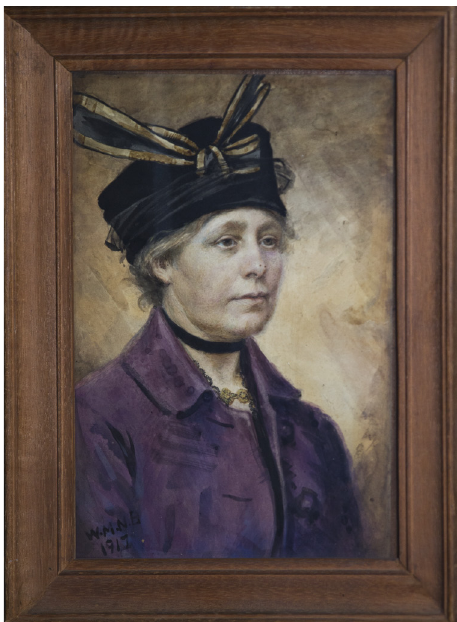
Fig. 3: Water-colour portrait of Margaret